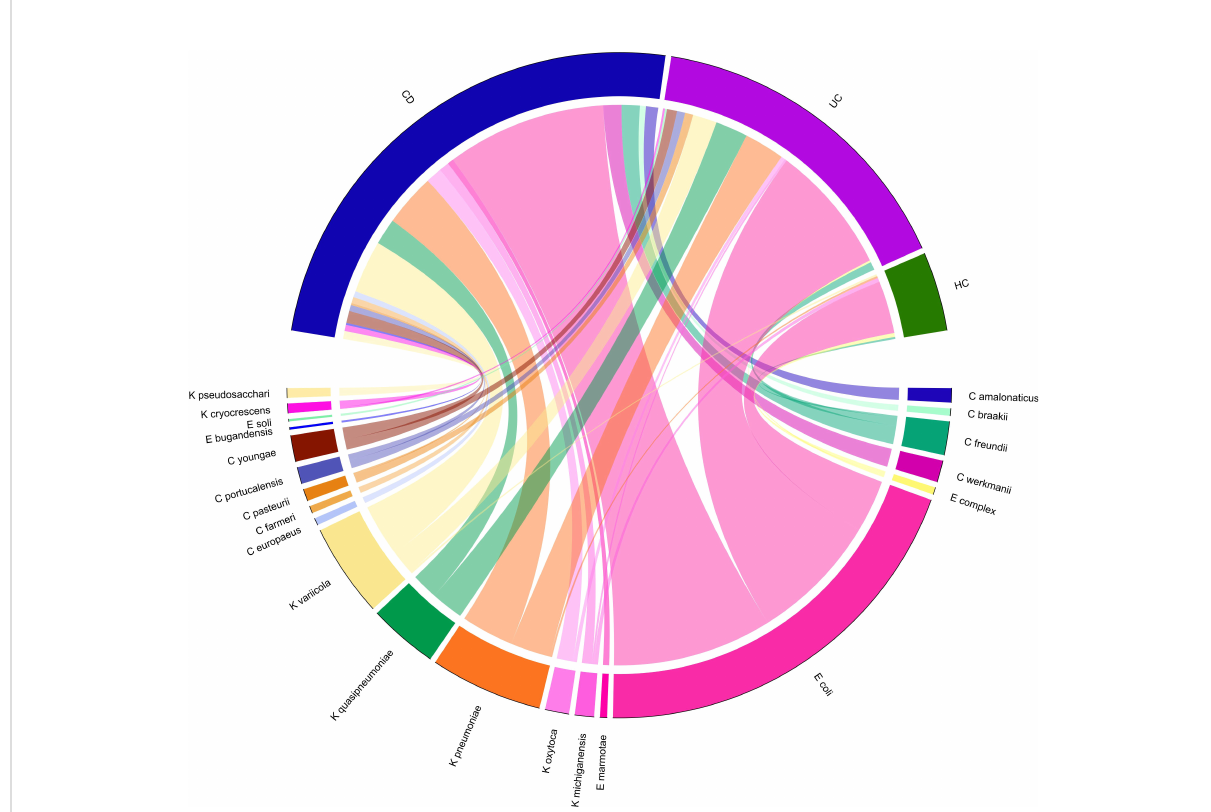
FIGURE 2 Chord-diagram visualizing the relative abundance of major Enterobacteriaceae species enriched in CD and UC compared to the HC groups. Circos plots show the correlation of the relative abundance of bacterial species within each group. Different Enterobacteriaceae species are separated by different